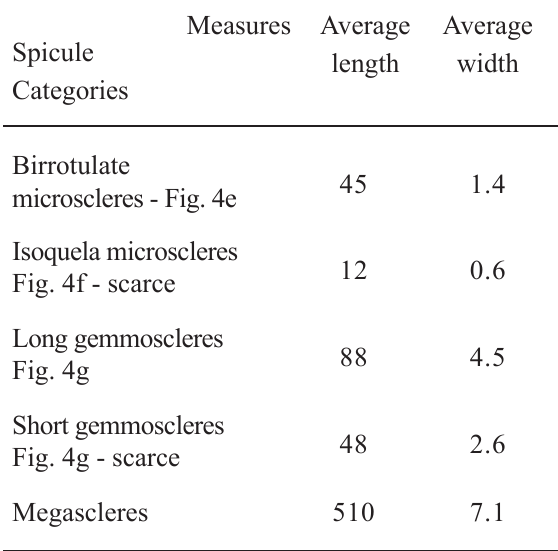
Category and measures (µm) of spicules of C. australis detected in the three studied sections. The longer slim and spiny birrotulate microscleres of the species present in sediments are quite thin and as such reduced to spiny